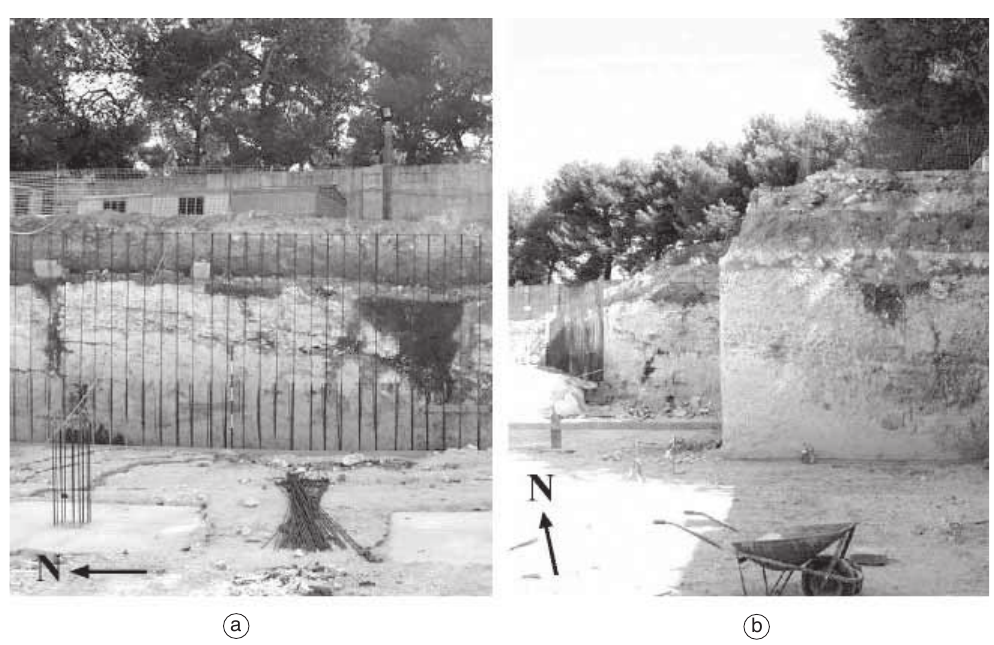
a Fig. 12a,b. Photo of the founding pit wall close to zone B revealing the presence of colluvial deposits and fractures in the calcarenite bedrock dipping to the south (a) and east (b).